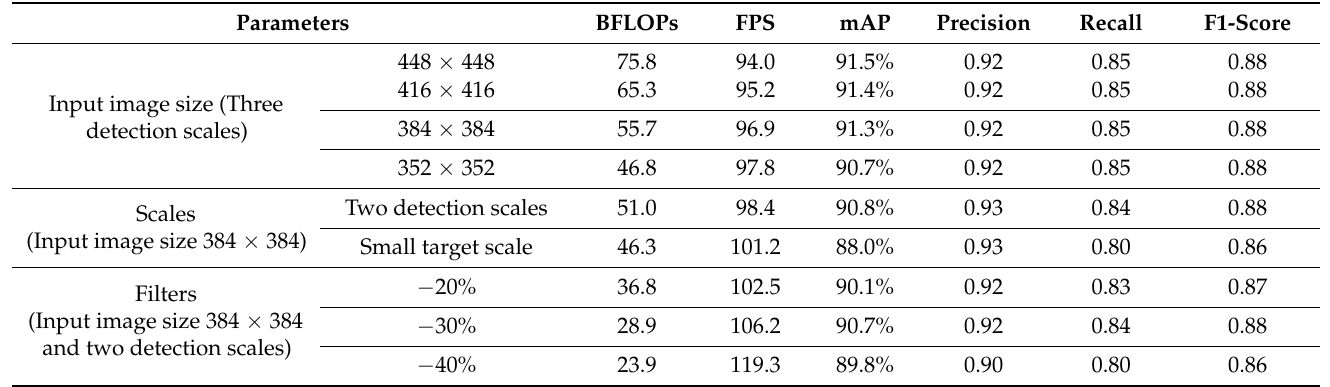
Table 2. Performance of Yolov3 on training data under different simulation